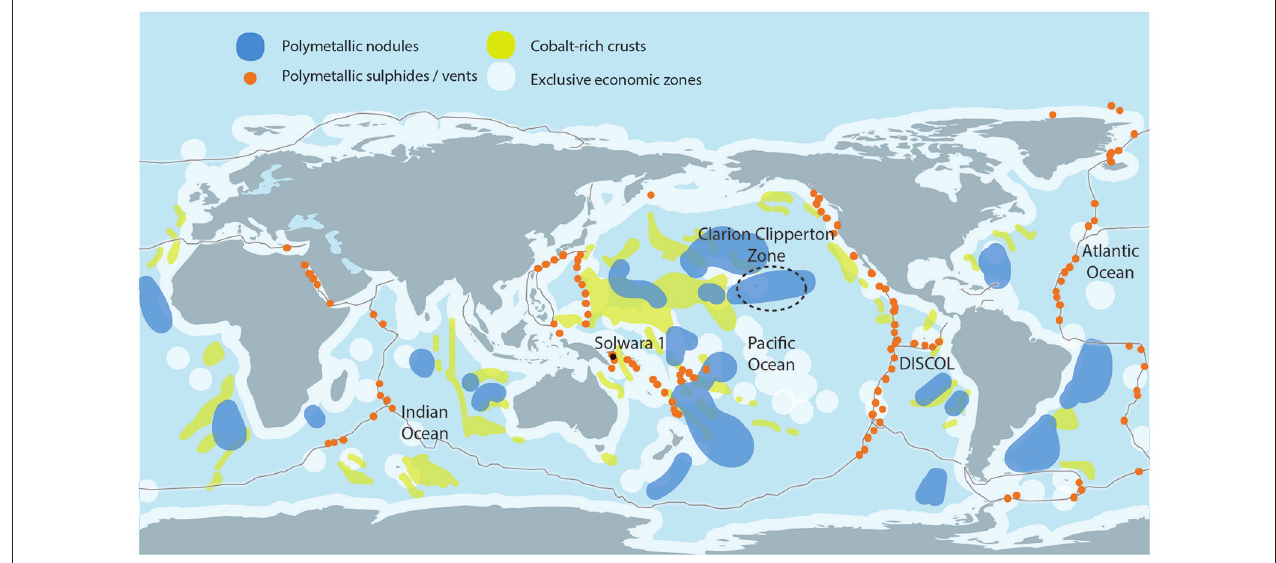
FIGURE 1 | A world map showing the location of the three main marine mineral deposits: polymetallic nodules (blue); polymetallic or seafloor massive sulfides (orange); and cobalt-rich ferromanganese crusts (yellow). Redrawn from a number of sources including Hein et al. (2013).